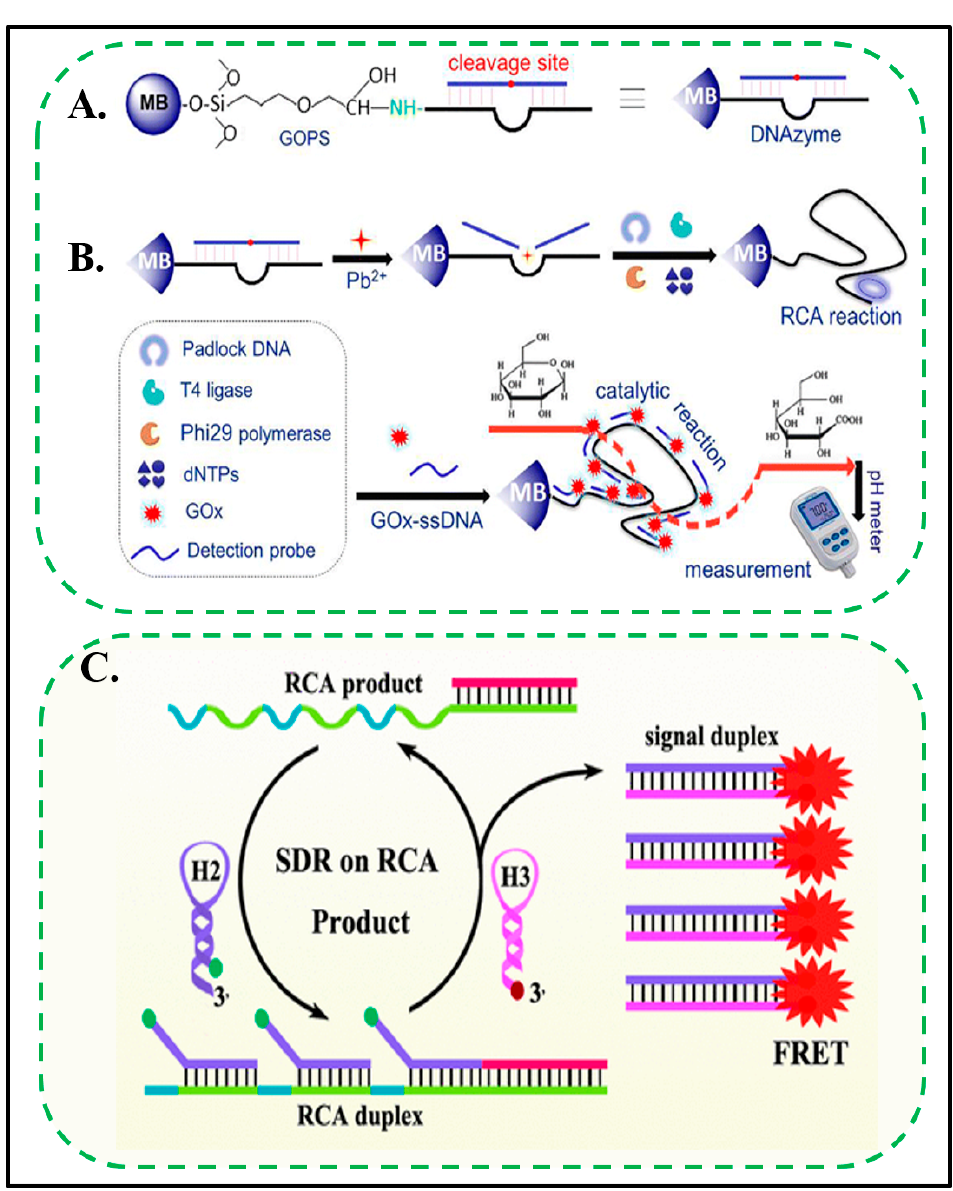
Figure 3. RCA assay for Pb 2+ detection. Adapted with permission from ref. [60,81]. ( A , B ) Illustration of metal-ion-induced DNAzyme on magnetic beads (MB) for the detection of Pb 2+ with rolling circle amplification (RCA) on a handheld pH metre; ( C ) Multisite-strand-displacement-reaction (SDR) signal-amplification strategy.